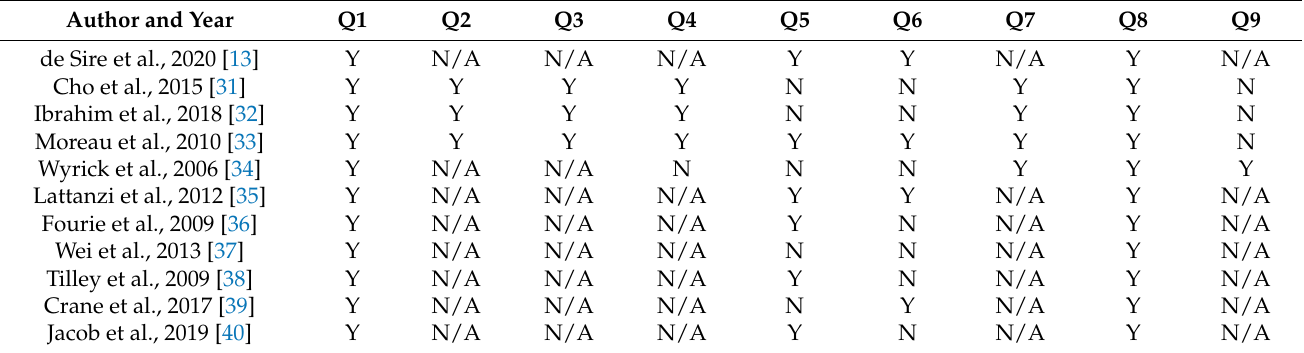
Table 3. Joanna Briggs Institute Critical Appraisal Checklist for Quasi-Experimental Studies (non- randomized experimental